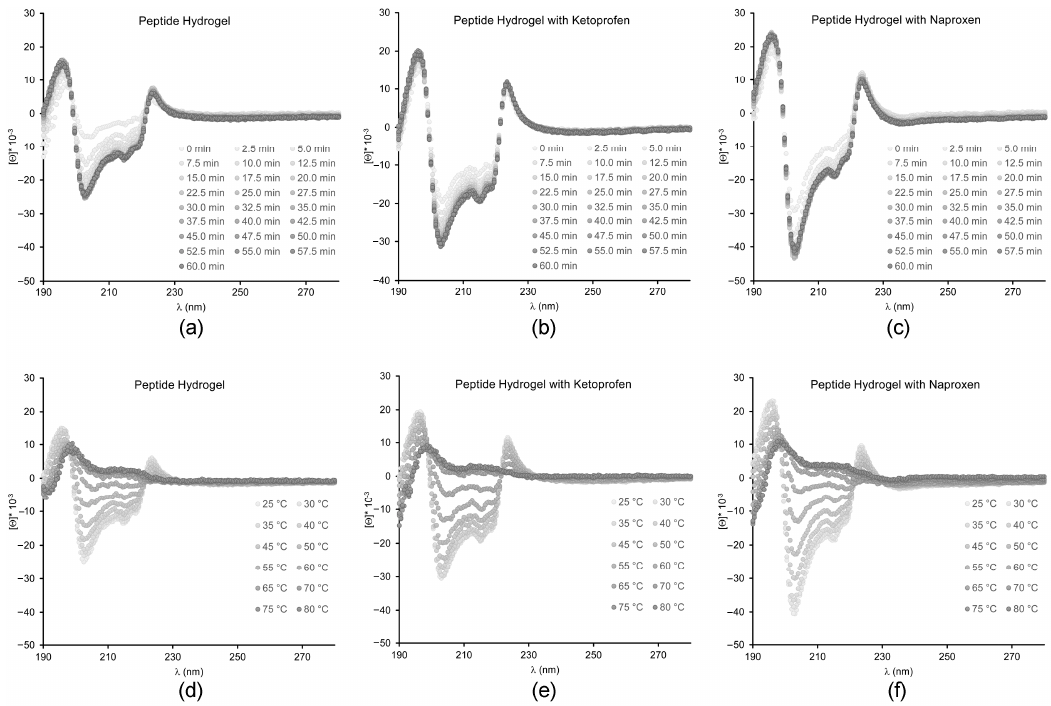
Figure 4. CD spectra of hydrogels; ( a – c ) kinetics over 60 min, ( d – f ) heating ramps up to 80 °C.